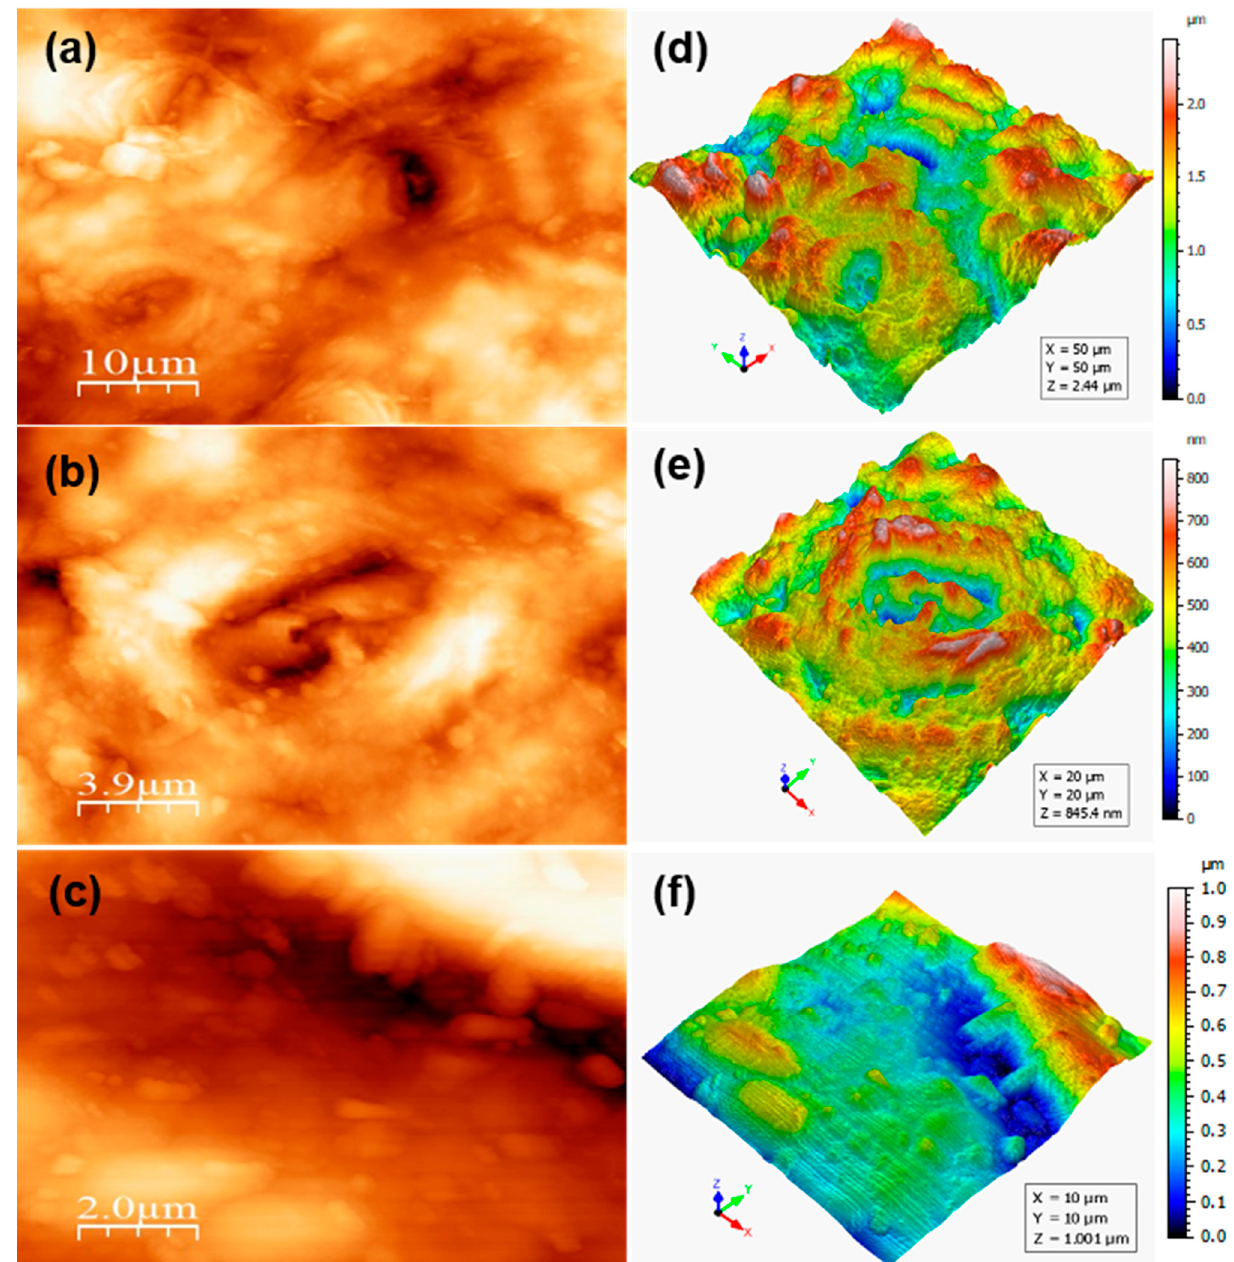
Figure 4. AFM topographical maps of Andiroba leaf surface of the abaxial side, highlighting 2D ( a – c ) and 3D ( d – f ) representations for maps with the size of 50 × 50 µm, 20 × 20 µm, and 10 × 10 µm, respectively.